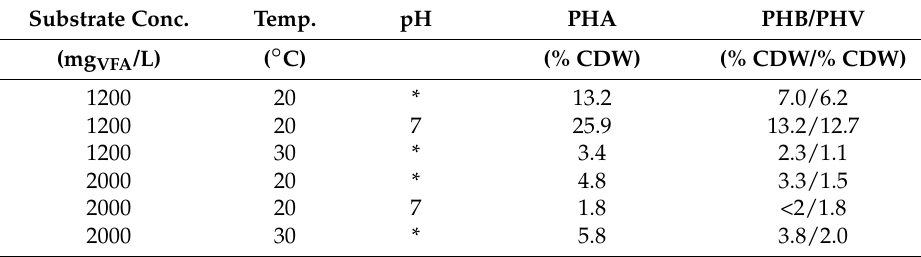
Table 4. PHA production in dependence of two tested substrate